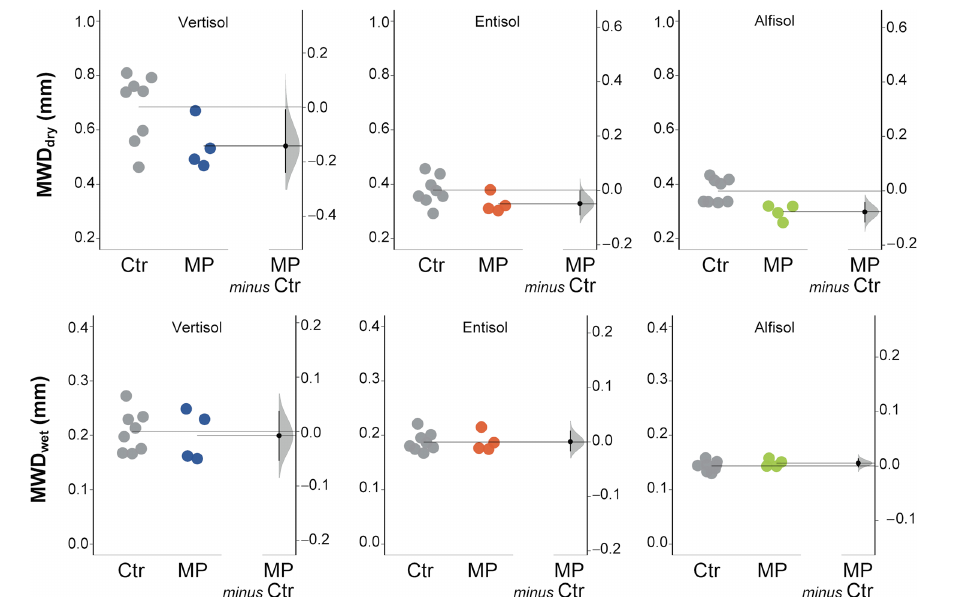
Figure 6. Mean weight diameter (MWD, mm) calculated from dry (MWD dry ) and wet (MWD wet ) sieving. Raw data of control (Ctr, gray dots) and polyester MP fibers added to the treatment (MP, colored dots) are shown in the plot for each soil. The filled curve indicates the resampled distribution of the mean differences ( (cid:49) ), given the observed data. Horizontally aligned with the mean of the test group, (cid:49) is indicated by the black circle. The 95% confidence interval of (cid:49) is illustrated by the black vertical line.